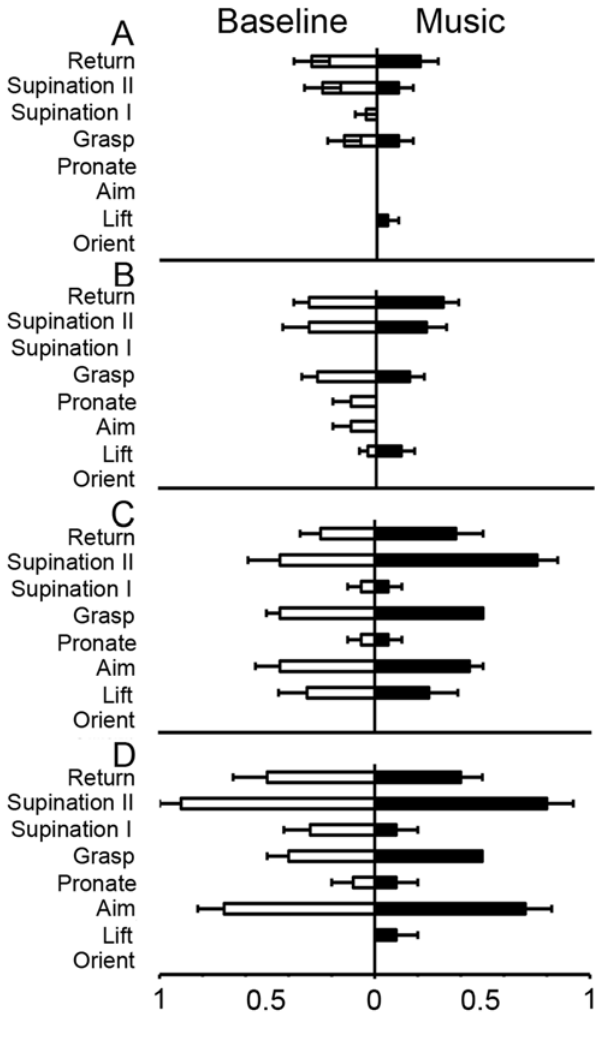
Figure 11. Movement element score (mean and standard error) for reaches completed at baseline (left) and preferred musical pieces (right) for A) YAC; B) OAC; C) mild PD; D) advanced PD. Note that music did not improve movement element